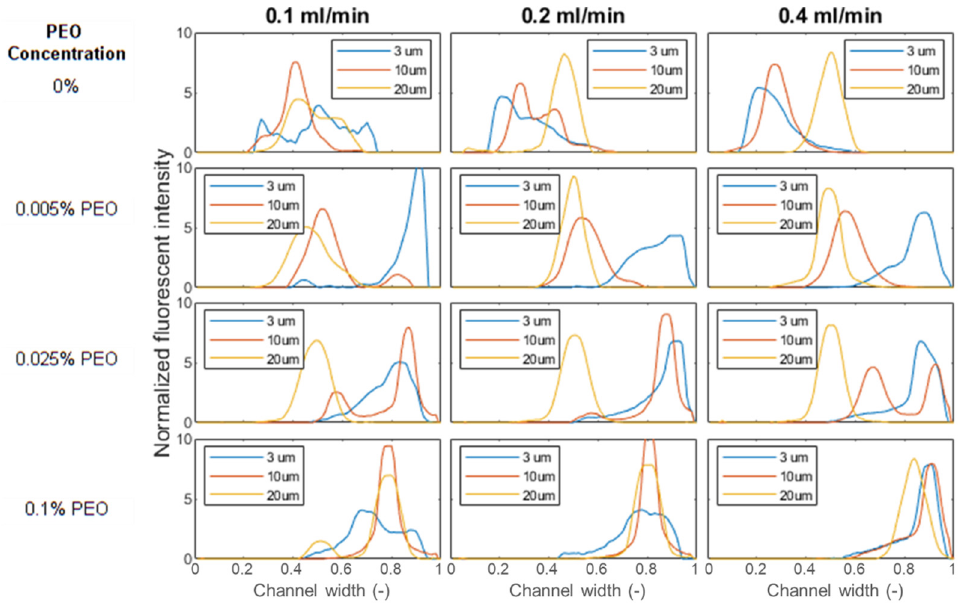
Figure 5. Plots showing focusing of 3, 10, and 20 µ m beads under varied flow conditions. Across the rows of the figure, the flow rate increases from left to right while the PEO concentration is increased down each of the rows. The x-axis shown in each figure is the normalized channel width from channel inner side wall to outer side